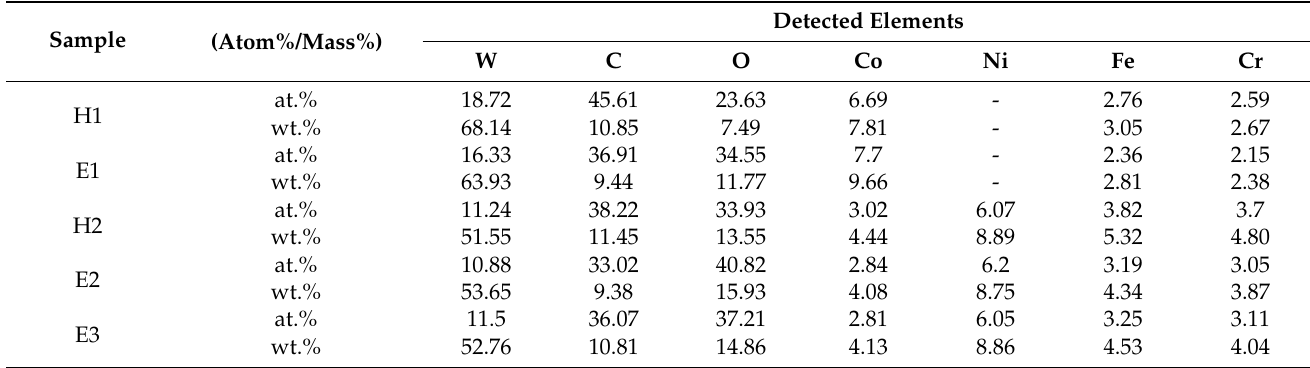
Table 6. Element contents from EDS detection.